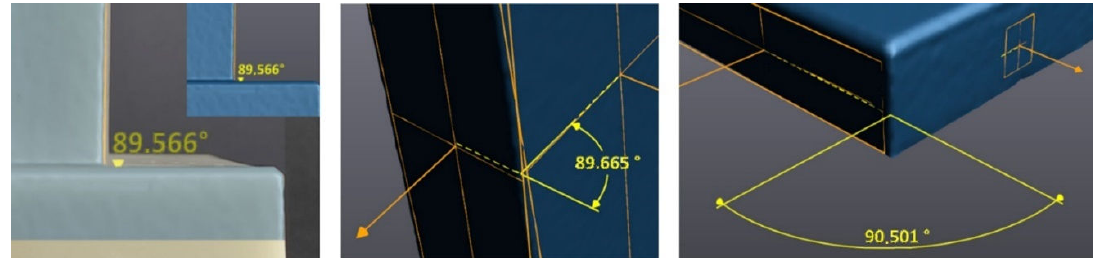
Figure 8. Assessment of the orthogonality preservation between the printed and scanned model.